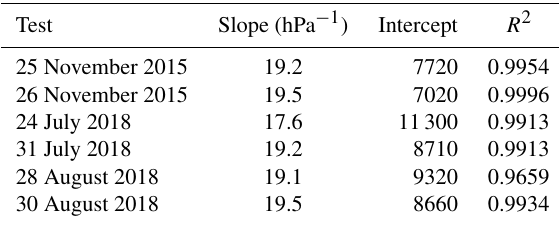
Table 3. Coefficients and R 2 obtained fitting a straight line to the test data shown in Fig. 1. “sml” denotes standard milliliters.